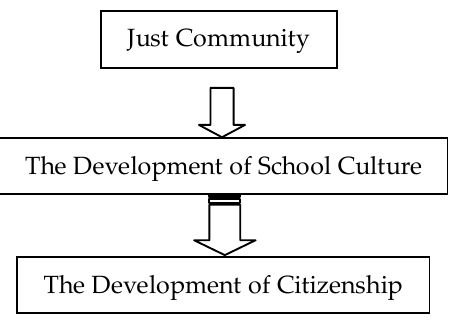
Figure 3. The Aim of Just Community